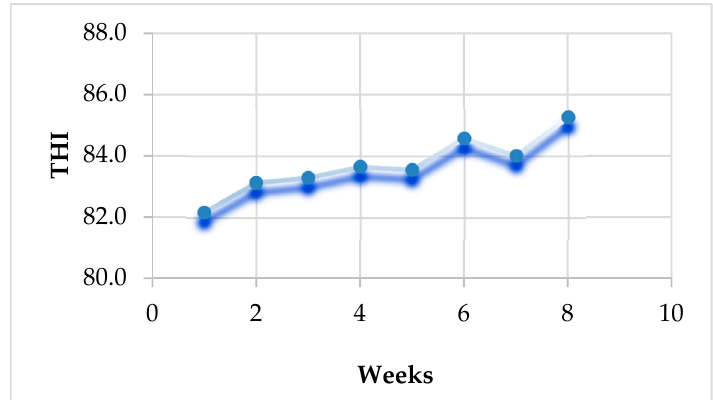
Figure 1. Calculated temperature humidity index (THI) throughout the experimental period.